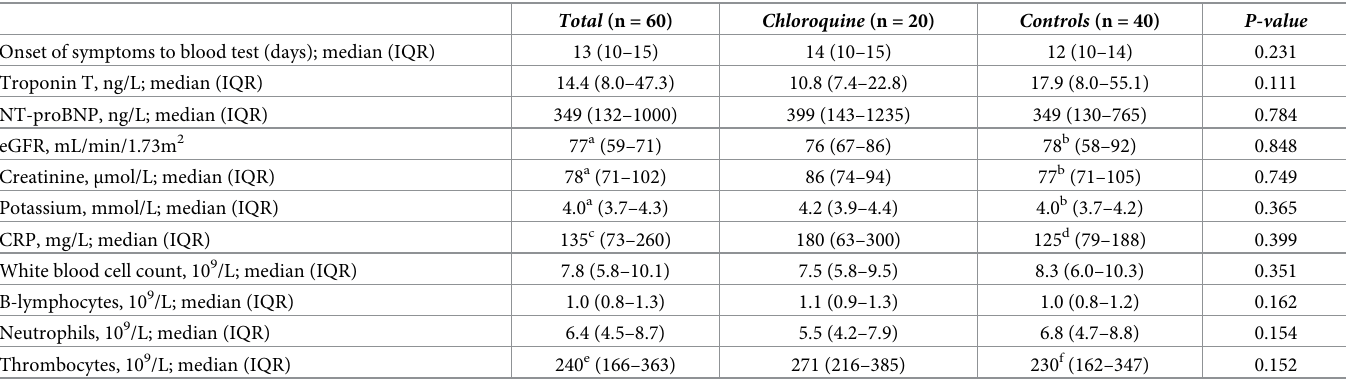
Table 2. Laboratory findings for study